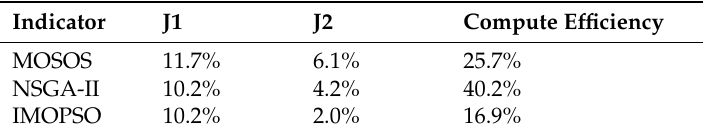
Table 8. Improvement ratio of IMOSOS compared with other